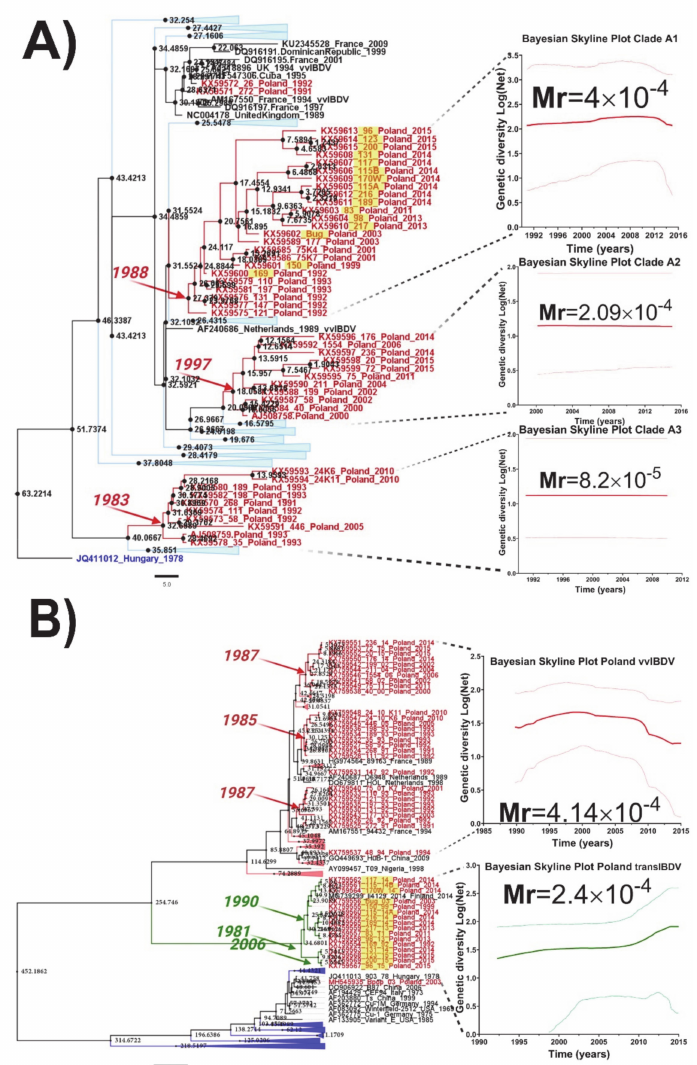
Figure 2. Evolutionary history and population dynamics reconstruction of Polish IBDV strains. ( A ) Max- imum clade credibility (MCC) tree based on 175 HVR sequences from the G3a genogroup of IBDV (left) clades A1–A3. The Polish VP2 strains were analyzed for the estimation of tMRCA and phylodynamic reconstruction (right) by a Bayesian skyline plot (BSP) using an exponential, uncorrelated clock model. The x -axis is in units of years, and the y -axis represents the logarithmic scale of Ne τ (where Ne is the effective population size and τ is the generation time). ( B ) MCC tree based on 175 VP1 sequences (left), clades identified within the vvIBDV lineage defined by Polish IBDV strains, and the intermediate B-linage recently reported by Pikuła et al. [32] strains were analyzed for estimation of tMRCA and phylodynamic reconstruction (right) by BSP using an exponential, uncorrelated clock model. The x -axis is in units of years, and the y -axis represents the logarithmic scale of Ne τ (where Ne is the effective population size and τ is the generation time). In all cases, Polish IBDV sequences are denoted in red, and the most probable year for the MRCA within each clade or lineage is denoted. The new intermediate B lineage is denoted in green. For simplification, those clades or lineages from sequences that were not directly related with the Polish sequences were collapsed. The rate of substitution per site per year (Mr) is denoted for each clade or lineage. The support of the clades of interest denoted in the figure were supported by a posterior probability value of pp =